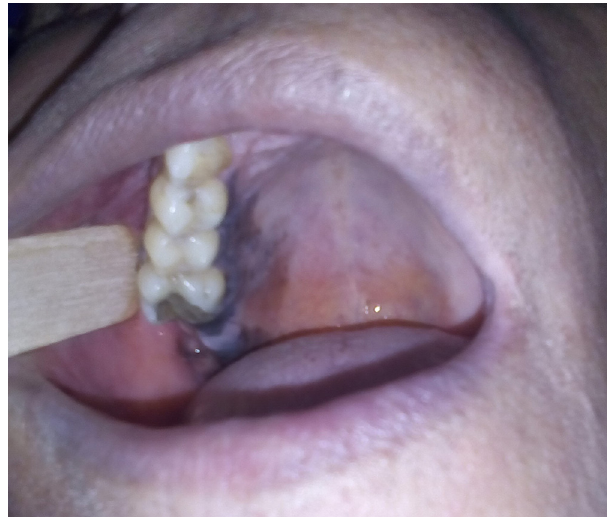
Fig. 1. A 56-year old man with a large mucosal pigmentation, extending from the right maxillary canine to the